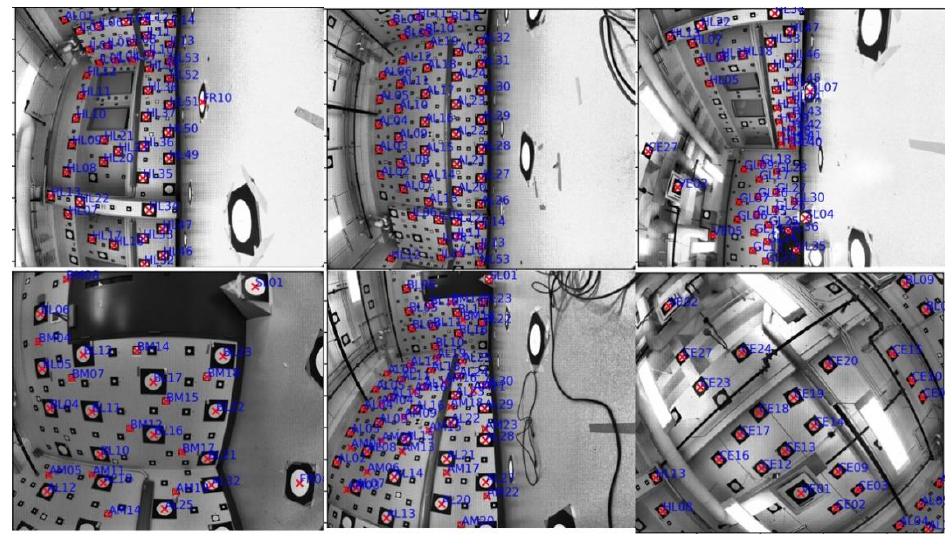
Figure 6. Selection of images from the Ladybug5 with detected and labelled